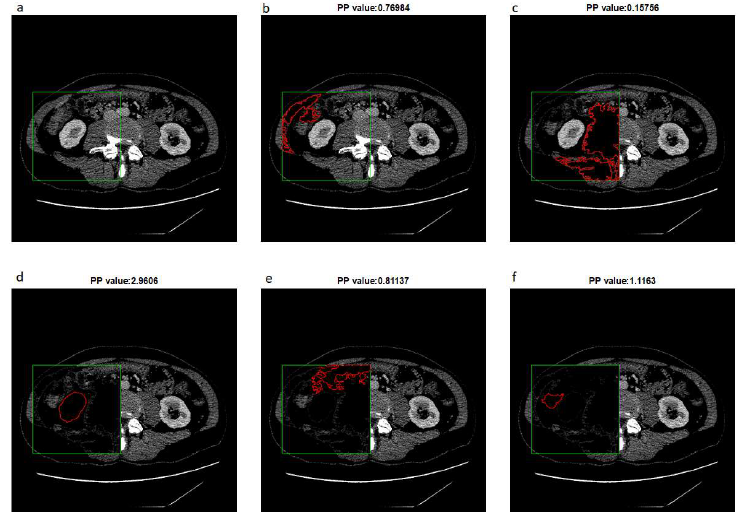
Figure 3. The result of the next five steps of extended-maxima transforms and result in removing. For example, ( a ) is an original image, and examples ( b – f ) show different shapes found in the next steps. calculated for each result.